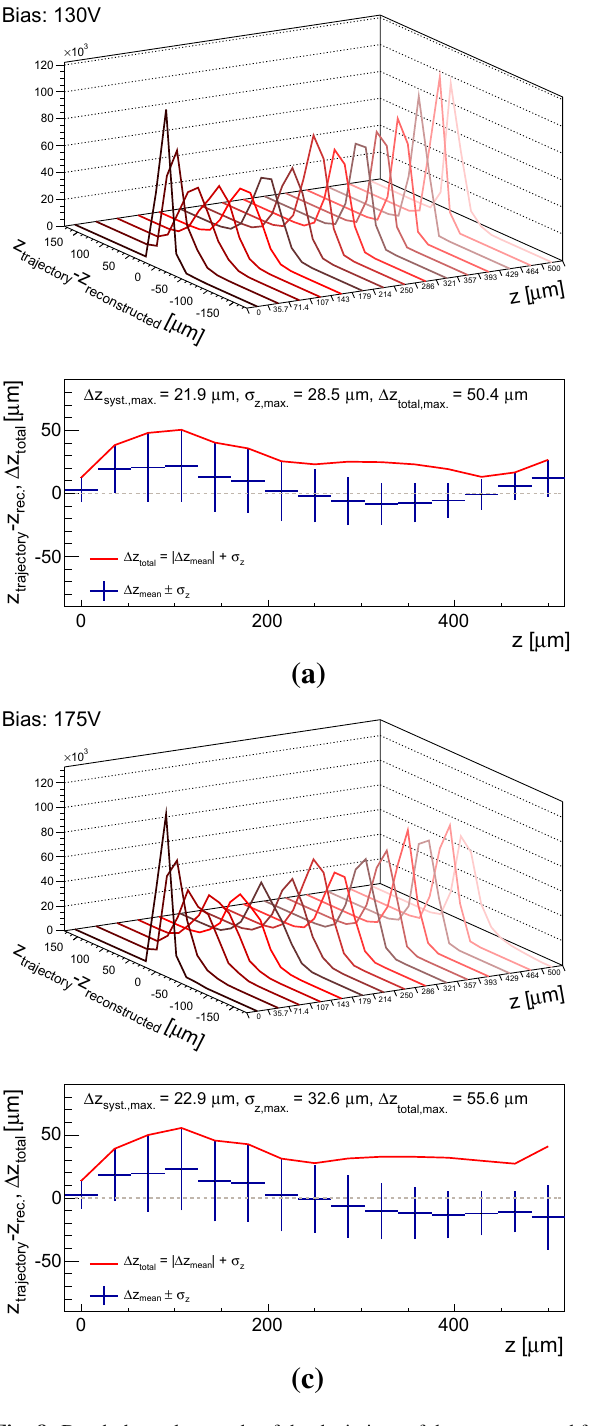
cathode contact was continuous. Since the cathode con- tact is pixelated, the electric field lines are bent towards the pixel electrodes, thus locally creating a stronger elec- tric field for low z values. For the measurements with